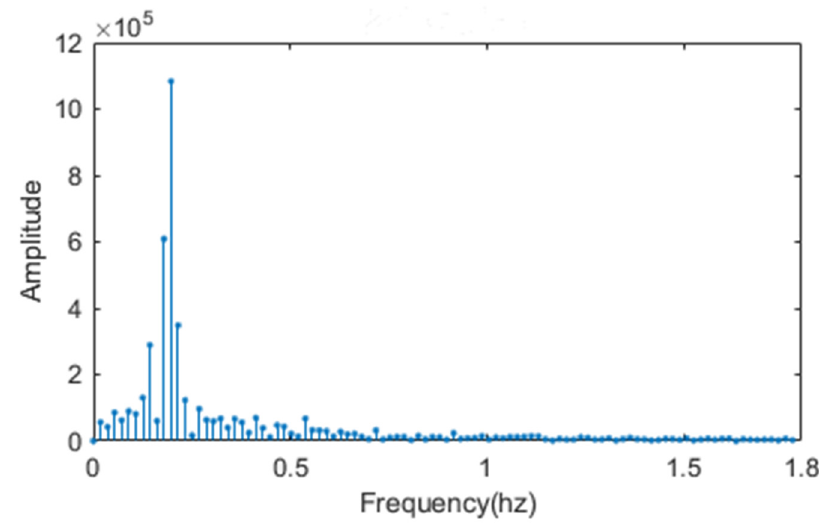
Figure 5. Amplitude–frequency characteristics of respiratory signals.